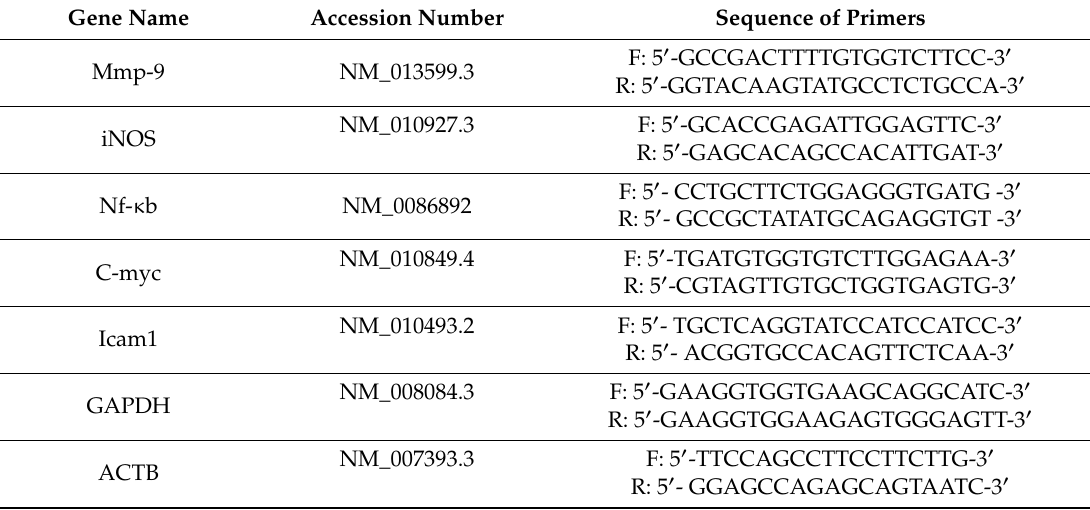
Table 1. List of the gene name, accession number, and sequence of the primers used in the real-time qPCR